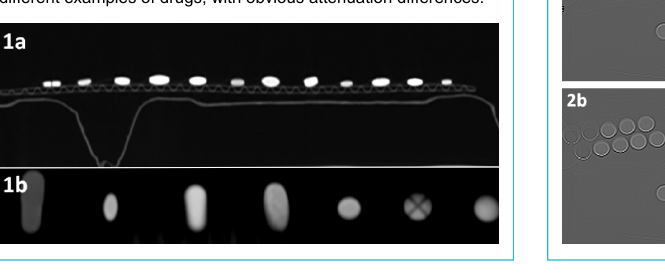
Figure 1: (a) Sagittal reconstruction of scan layout with dens pills attached to cardboard kidney basins and (b) coronal close up of different examples of drugs, with obvious attenuation differences.